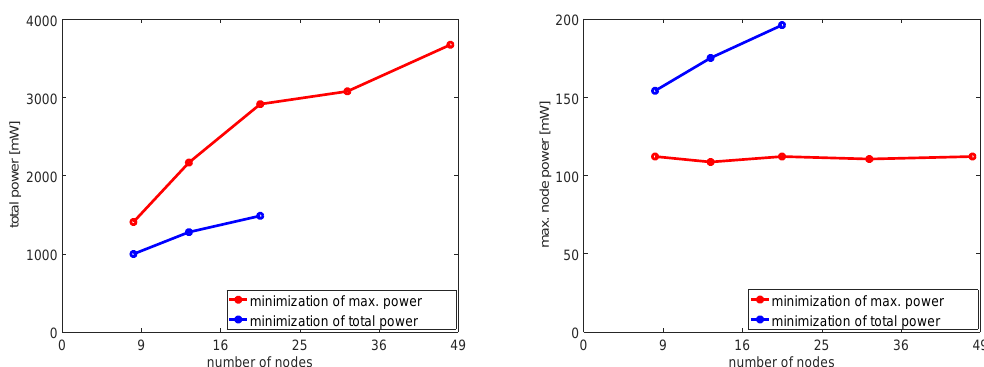
Figure 5. Average values of total energy performance index (left graph) and maximum node energy performance index (right graph) for both